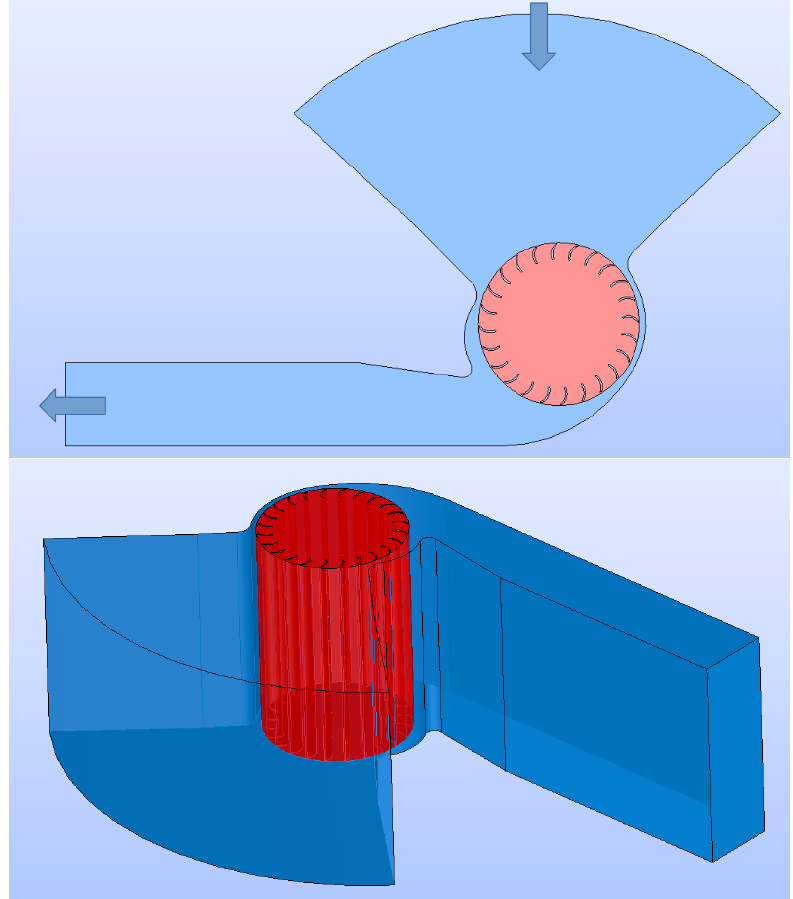
Figure 19. Computational fluid volume of the CFF.